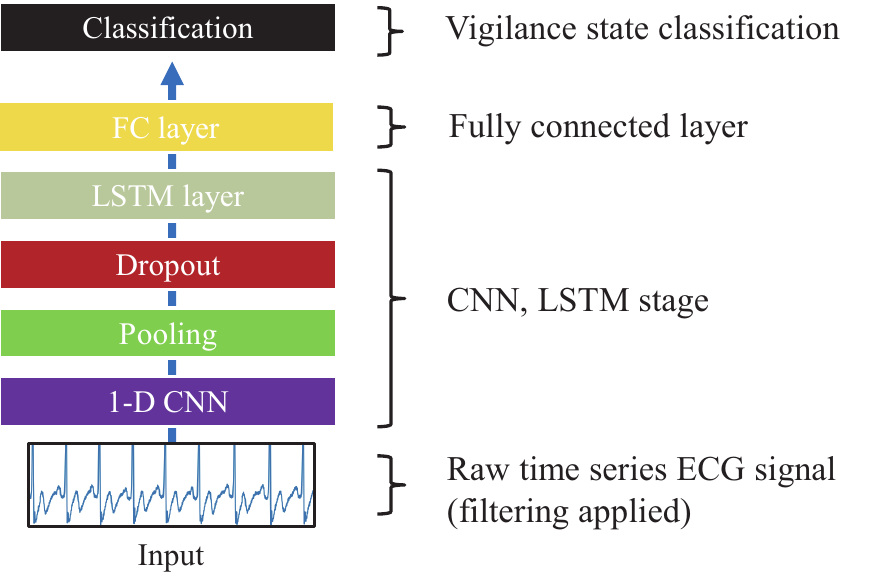
Figure 1. Deep- ECGNet model structure, which consists of a 1D CNN, LSTM, and fully connected layer for extracting electrocardiogram (ECG) features.